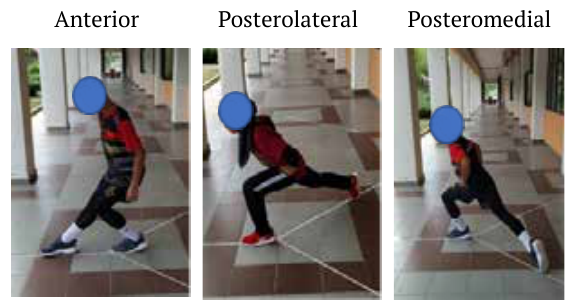
Figure 2. Y-Balance Test